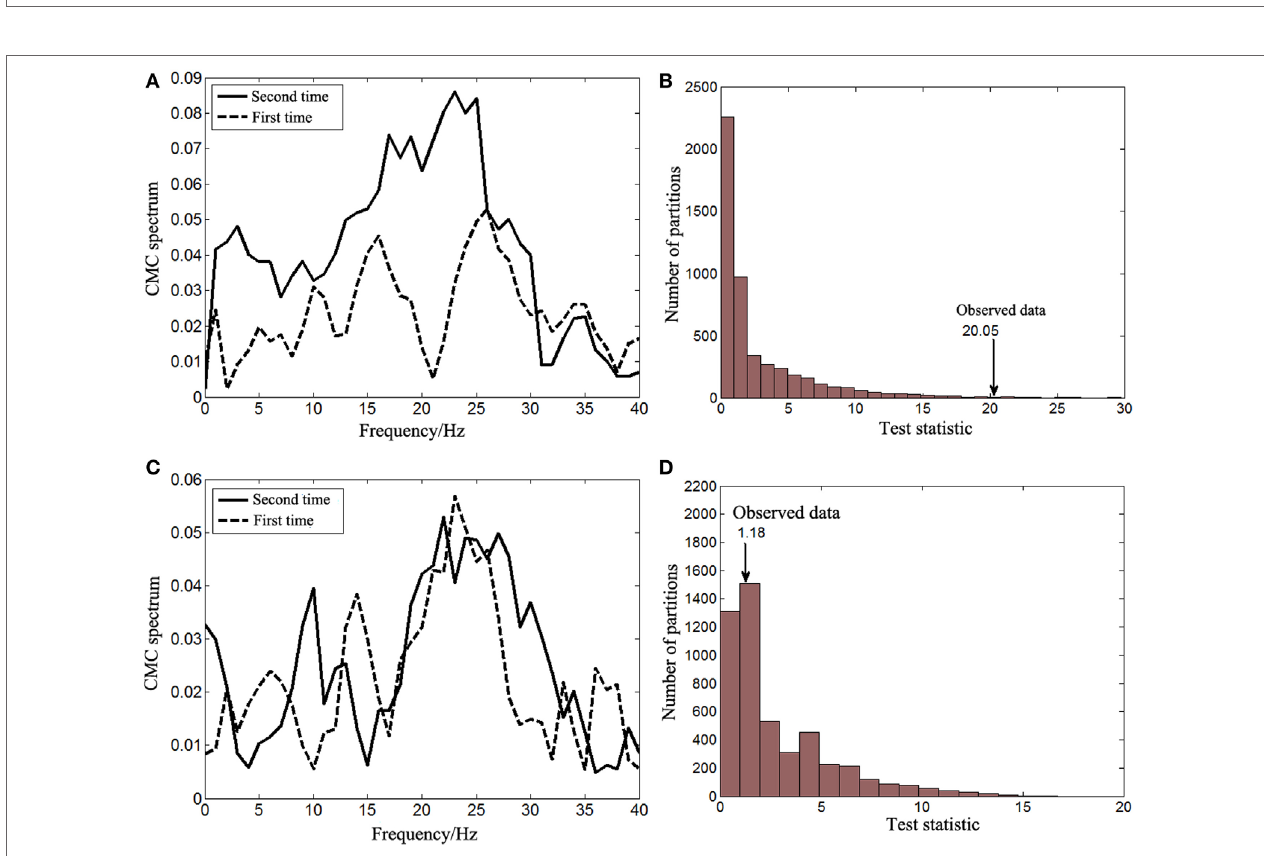
FIgURe 4 | The corticomuscular coherence (CMC) spectrum between activities from the right motor cortex and the left biceps brachii (a) and the results of the corresponding statistical analysis for the beta-band CMC differences between two times of experiments (B) . The CMC spectrum between activities from the left motor cortex and the right biceps brachii (C) and the results of the corresponding statistical analysis for the beta-band CMC differences between two times of experiments (D) .